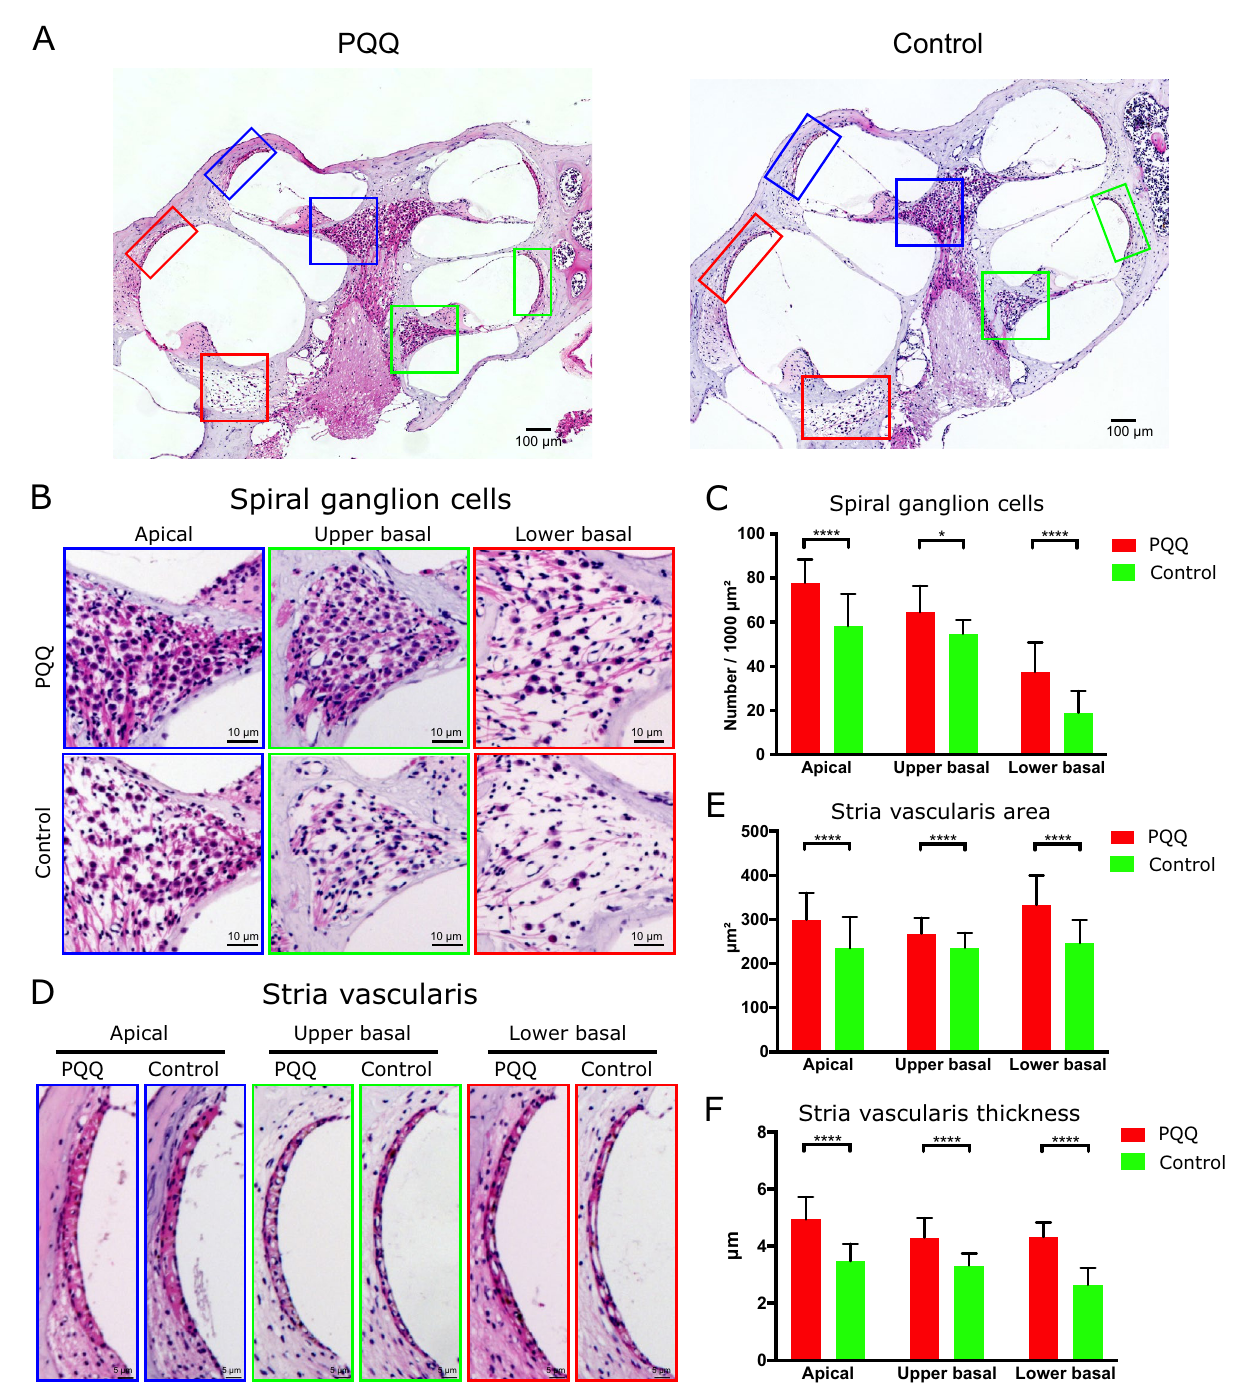
Figure 7. Histological evaluation of the spiral ganglion and the stria vascularis in the age-related hearing loss model ( A ) The histological H-E images of the cochlea in each group showing the spiral ganglion cells (SGCs) (square) and the stria vascularis (SV) (rectangle) at apical (blue), upper basal (green) and lower basal (red) turns. Bar, 100 µm. ( B ) SGCs. Bar, 10 µm. ( C ) The densities of SGCs per 1000 µm 2 . ( D ) The SV. Bar, 5 µm. ( E, F ) The area ( E ) and the thickness ( F ) of the SV. * p < 0.05, **** p < 0.0001. (Control group (n = 10) and PQQ group ( n =